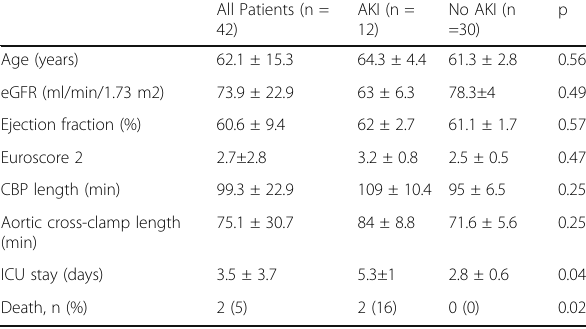
All Patients (n = 42)